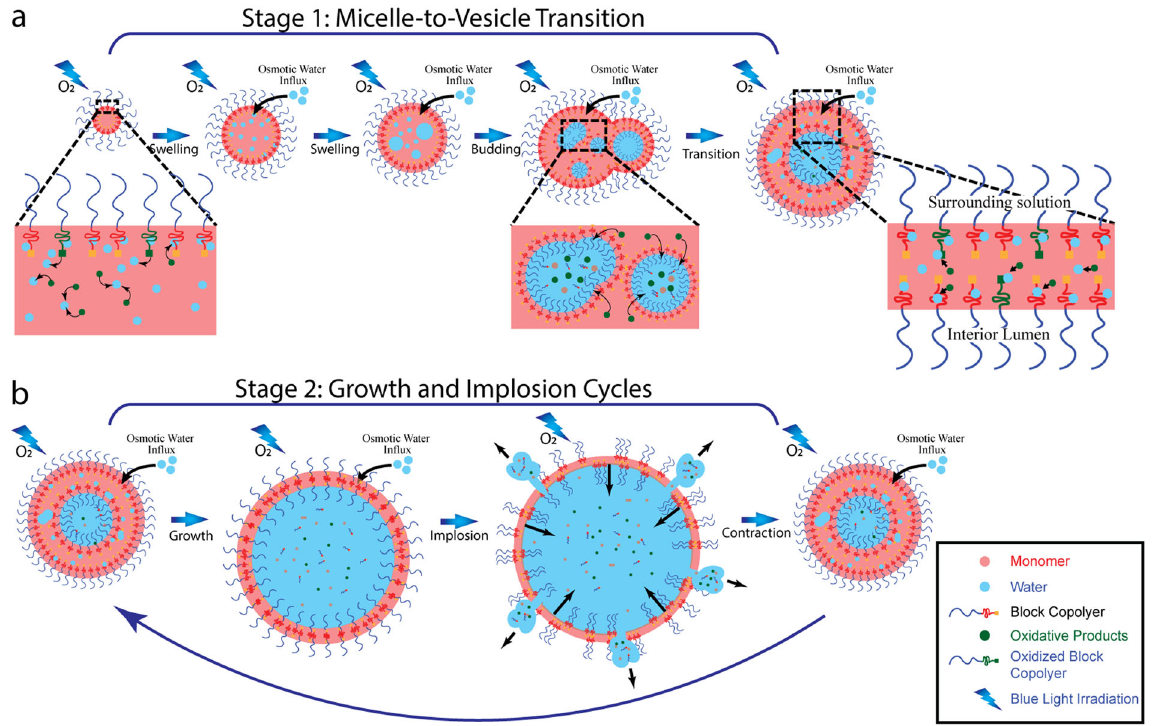
Fig. 6 Schematic illustration of proposed mechanism for Phoenix dynamics. a Stage 1: Under exposure of oxygen and blue light irradiation, supramolecular polymer objects transit from micelles to vesicles through a series of intermediate morphologies due to degradation-induced osmotic water in fl ux; b Stage 2: The resulting vesicles undergo size growth-implosion